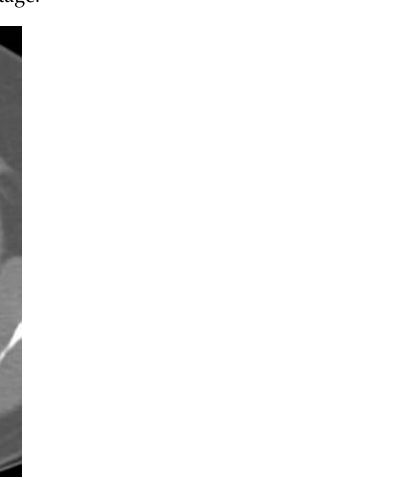
Table 5. Number of patients undertaken 64-slice MDCT and 256-slice MDCT in group 1 and 2. Group 1 ( n = 42) MDCT indicates multi-detector CT. Parenthesis indicates percentage.